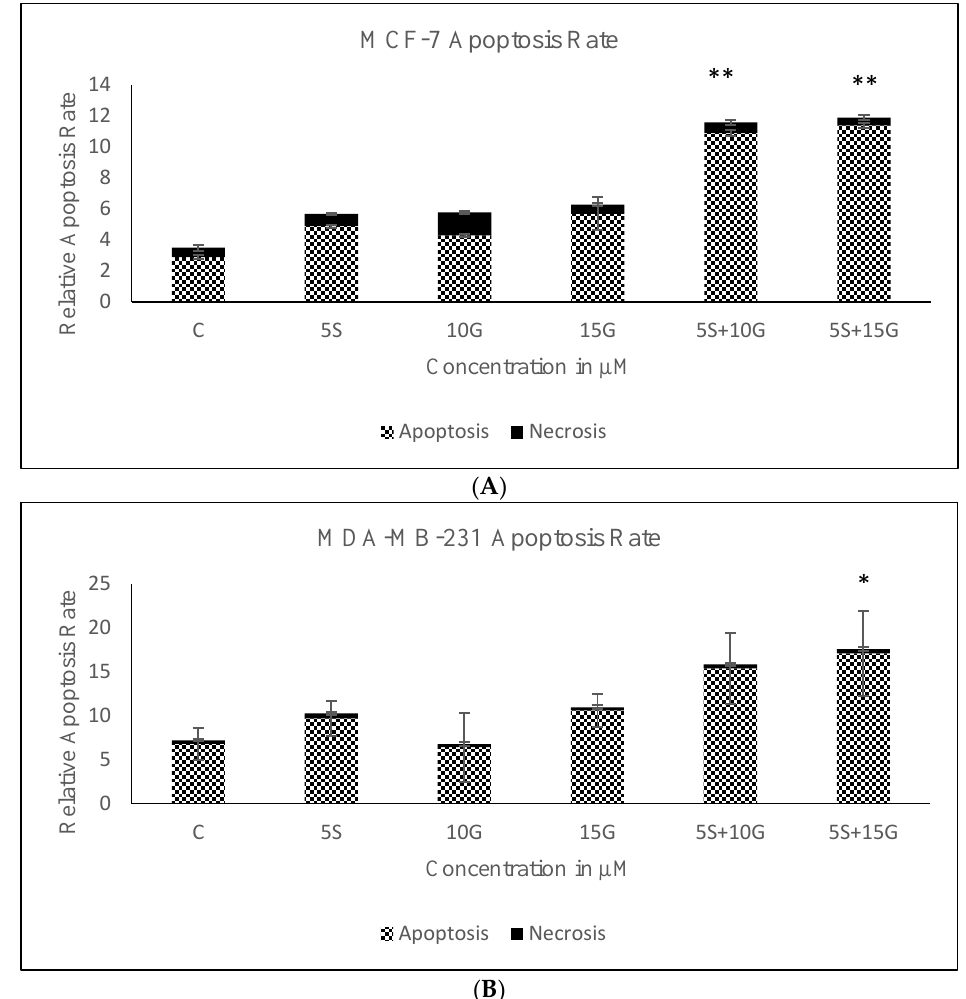
Figure 4. Apoptosis assay. Treatment with a combination of GEN and SFN promotes apoptosis in breast cancer cells (* p < 0.05, ** p < 0.01). ( A ) annexin V apoptosis analysis assay employing Fluorescence-activated Cell Sorting (FACS) analysis was performed on MCF-7 cells for three days at the indicated concentrations. The results represent three separate experimental replicates. Numbers on the x -axis indicate compound concentrations; ( B ) annexin V apoptosis analysis assay using FACS analysis was performed on MDA-MB-231 cells for three days at the indicated concentrations. The results represent three separate experimental replicates. Numbers on the x -axis indicate compound concentrations. Data are presented as mean ± SD.